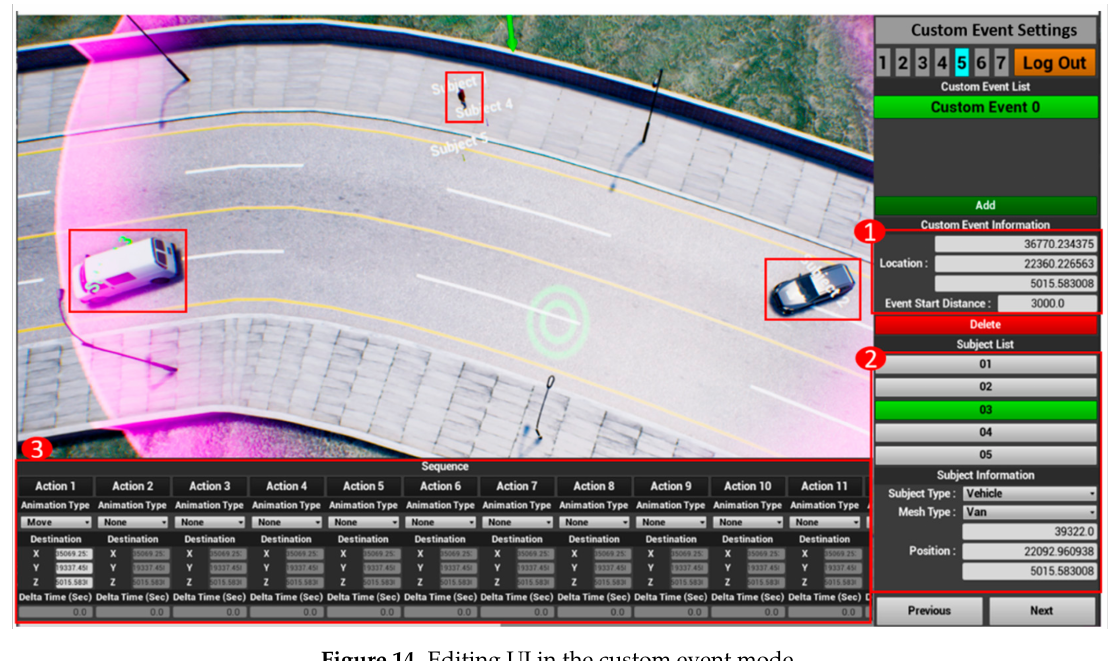
Figure 14. Editing UI in the custom event mode.